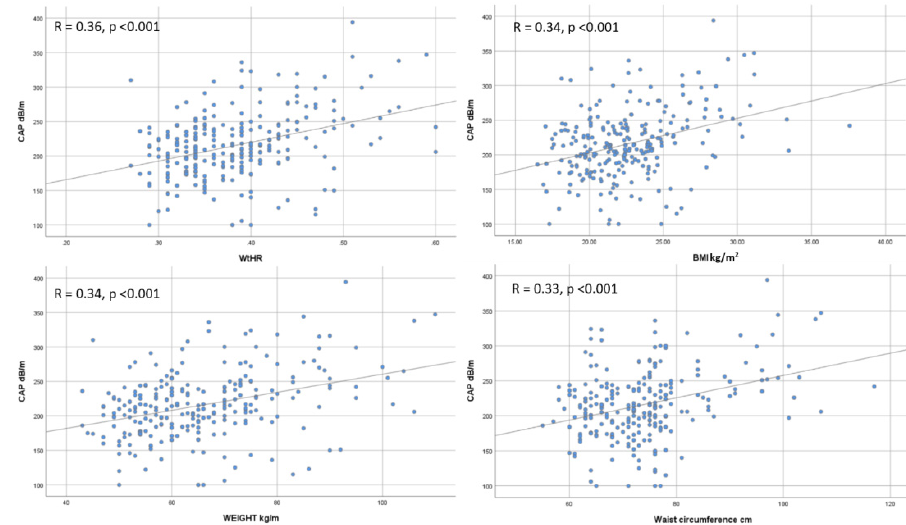
Figure 3 . Correlation between CAP and WtHR (Figure 3A), BMI (Figure 3B), Weight (Figure 3C), Figure 3. Correlation between CAP and WtHR ( A ), BMI ( B ), Weight ( C ), and Waist circumference ( D ). and Waist circumference (Figure 3D) .